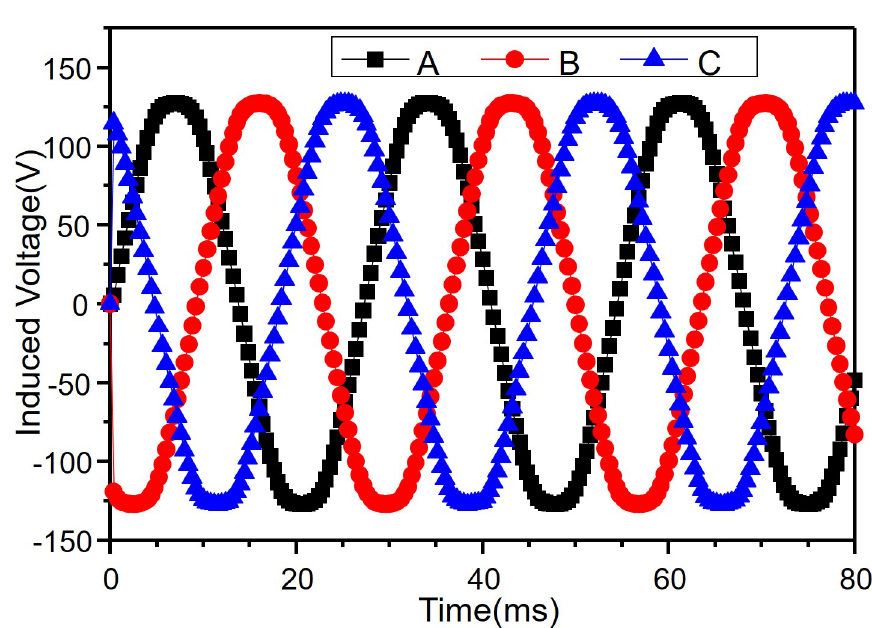
Figure 18. Waveform of three-phase back electromotive force under